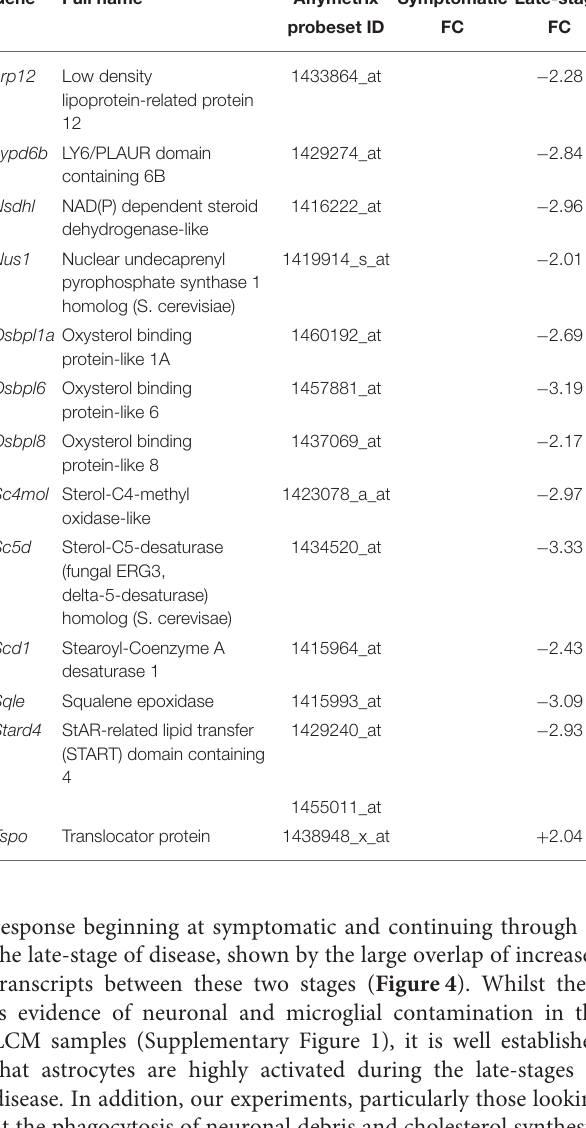
TABLE 4 | Transcripts involved in cholesterol homeostasis that are differentially expressed in symptomatic and late-stage SOD1 G93A astrocytes vs. NTg controls ( p ≤ 0.05 , FC ≥